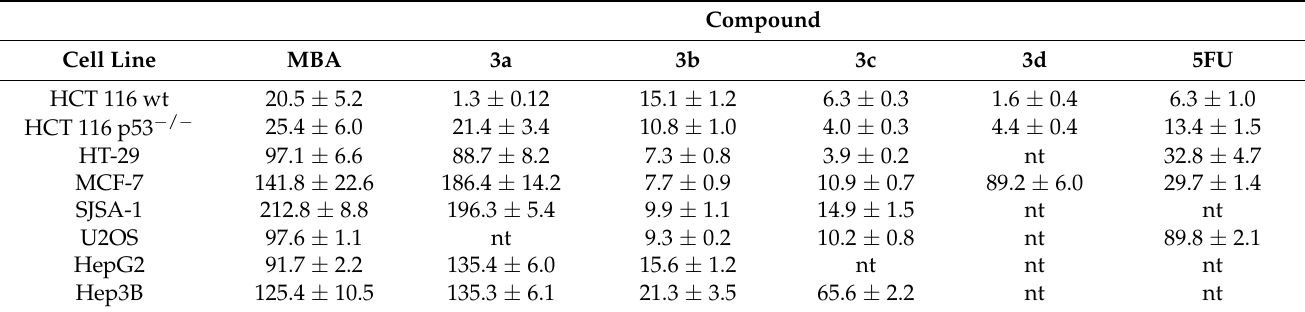
Table 2. Cytotoxicity of MBA derivatives and 5FU against multiple cancer cell lines (nt—not tested). Cell Line